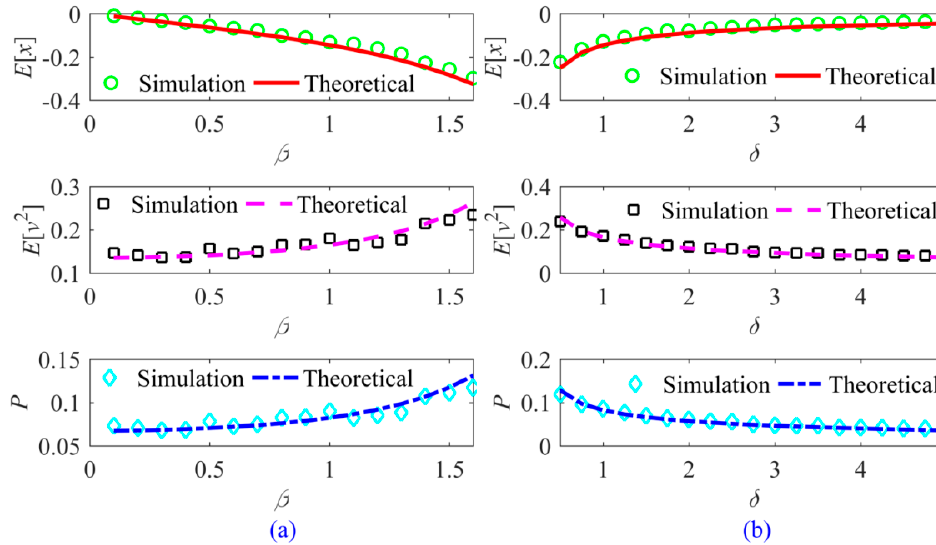
Figure 4. Influence of ( a ) quadratic coefficient and ( b ) cubic coefficient on the mean displacement, mean square voltage, and power output.